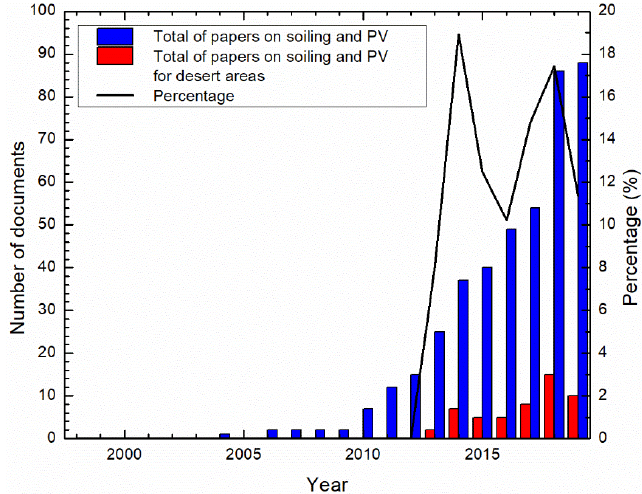
Figure 1. Number of papers published in the last 20 years according to the Scopus source under the search terms “soiling” and “photovoltaics”, and “soiling” and “photovoltaics” and “desert”. The full line represents the percentage of papers published on the subject of deserts, compared to the total. Accumulation of soiling and the losses caused are phenomena greatly depending on the local environment and the type of PV technology. The daily amount of deposited soiling, soiling rate, or daily dust accumulation, depends on environmental conditions, kind of surface, atmospheric dust concentration, dust chemical composition, distance to dirt sources, and rainfall, among others [7].